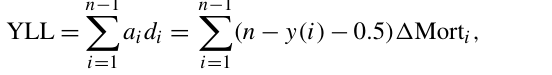
number of years remaining, as shown in Eq.